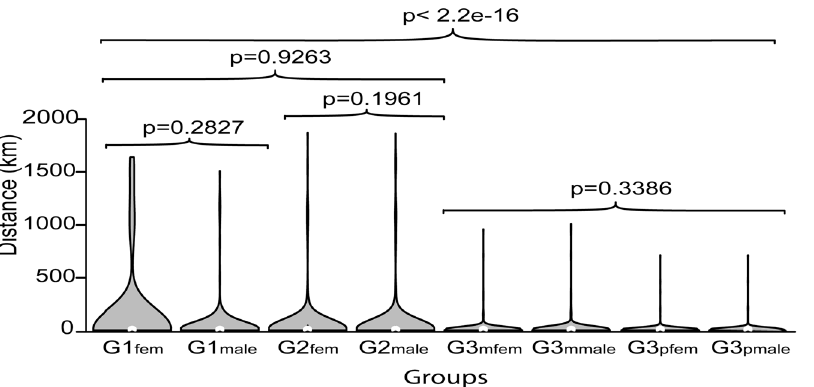
Figure 2. Density plots combining migration distance and frequency of the distance for each group. Wilcoxon Rank tests were performed for G1 and G2 within generation comparisons and Kruskal-Wallis tests were performed for G3 within generation comparison and between generation comparisons. P-values are shown for the respective tests.